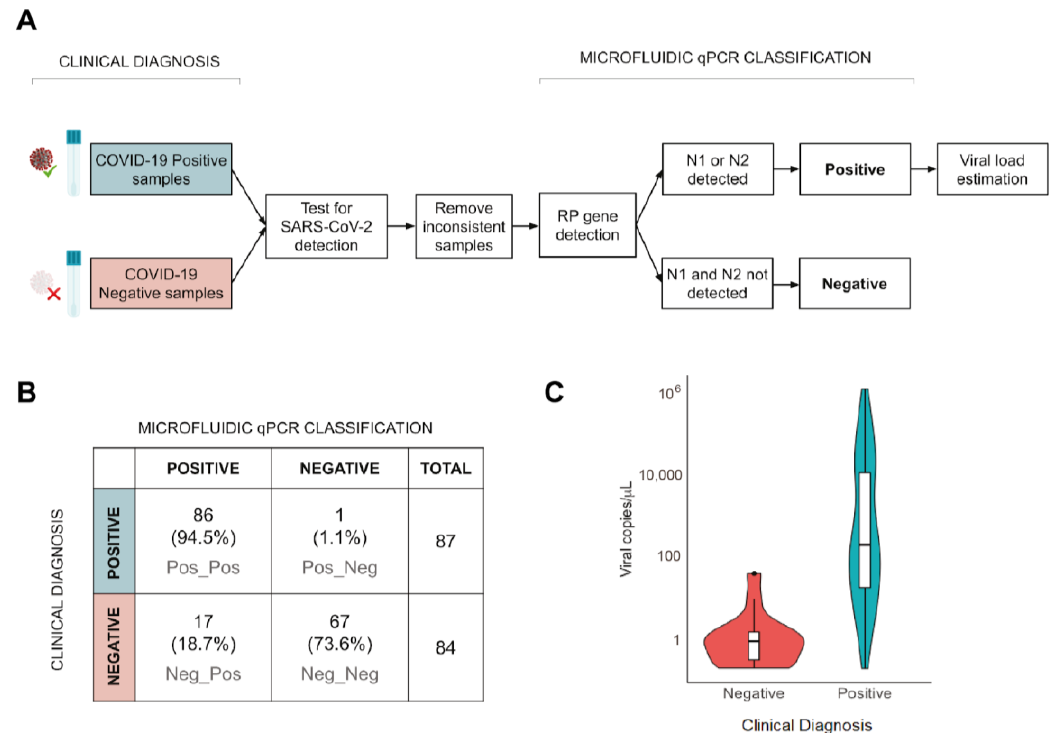
Figure 3. The three-step nano-scale RT-qPCR method shows higher sensitivity in detecting samples with low viral-loads. ( A ) Workflow for the re-analysis of clinical samples (SARS-CoV-2 positive and negative) from an accredited diagnostic lab. ( B ) Comparison between clinical diagnosis and the microfluidic qPCR classification. Category labels indicate clinical diagnosis followed by microfluidic qPCR classification (e.g., Neg_Pos = negative diagnosis, positive microfluidic qPCR result). ( C ) Viral load estimates for di ff erent categories of classified samples based on microfluidic qPCR. Samples with a negative clinical diagnosis contained very low viral loads ( < 100 copies / µ L). Viral titers of samples in plate 1 and 2 were computed using the standard curve of plasmid controls from plate